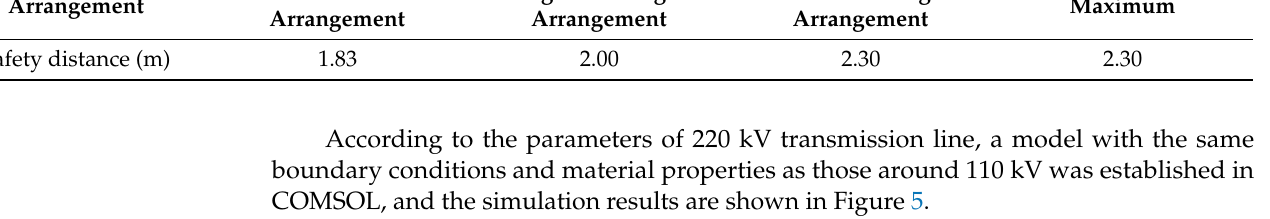
Figure 4. Electric field distribution around transmission lines with different arrangement of 110 kV voltage levels. ( a ) Field strength distribution under 110 kV inverted triangle arrangement; ( b ) field strength distribution under 110 kV horizontal arrangement; ( c ) field strength distribution of the 110 kV regular triangle.